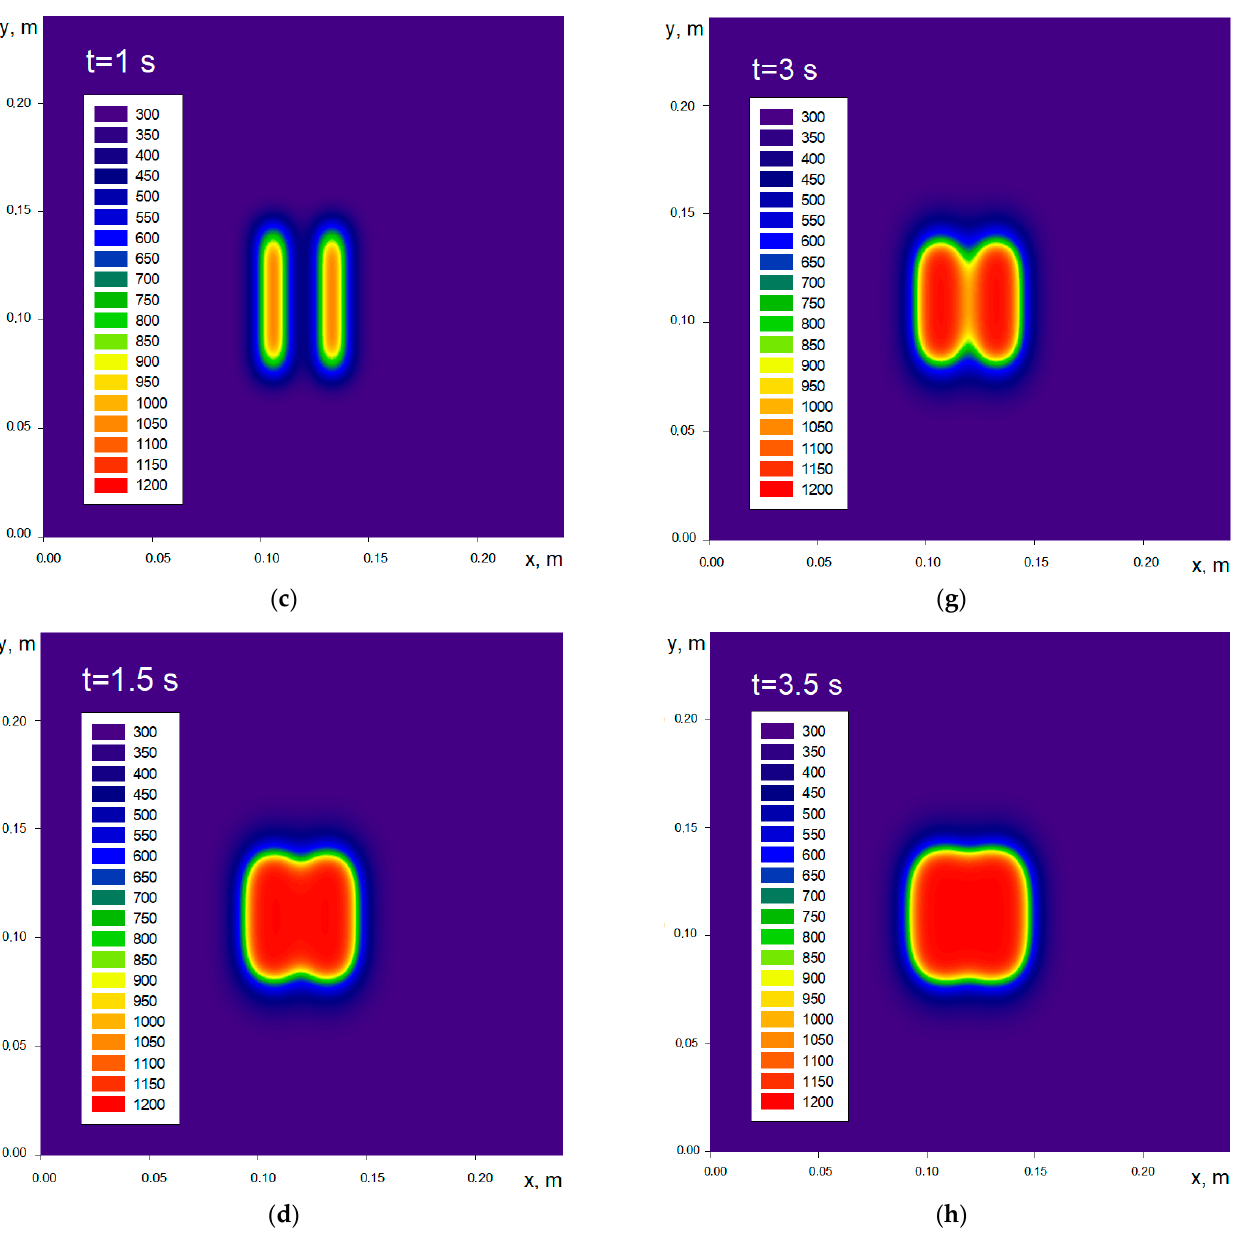
Figure 6. Isotherms on the wood layer surface: at different moment L = 69 mm, d = 7.5 mm, h = 16.6 mm, ∆ t = 0.